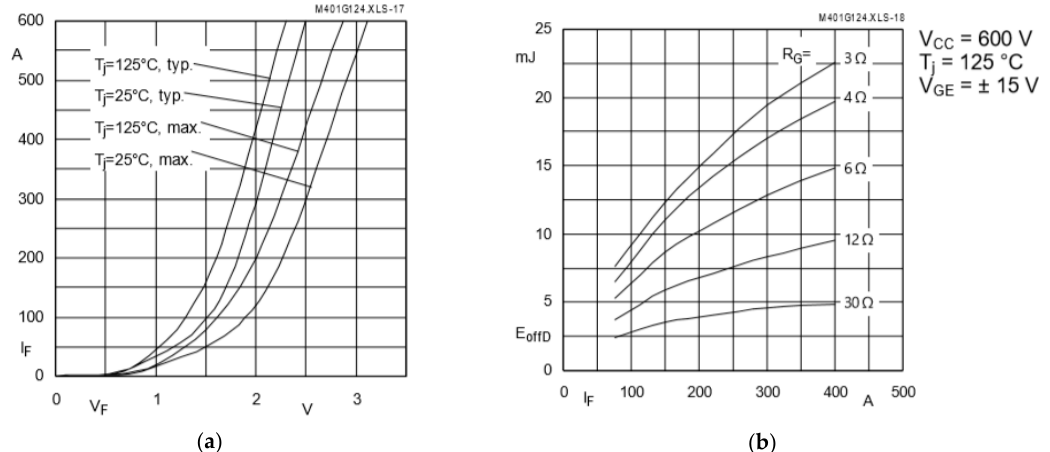
Figure 5. Diode features. ( a ) Diode characteristic ( b ) Diode turn-off losses.